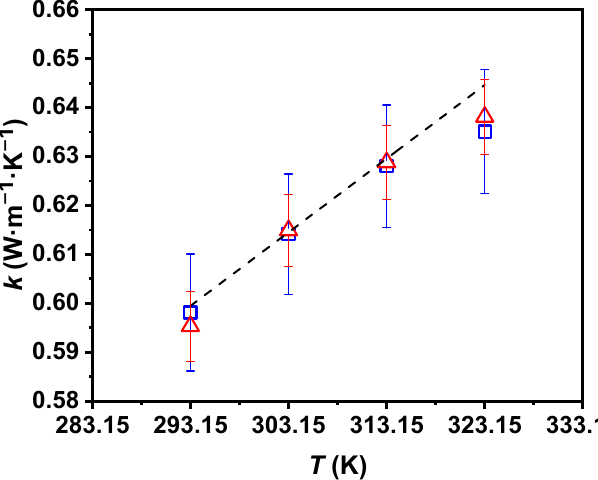
Figure 3. Experimental thermal conductivity, k , of 0.50 wt% P-GnP/W nanofluid (UVigo (cid:3) ; ILK laboratory, (cid:52) ) together with the literature k of water (- - -) [55] as a function of temperature, laboratory, □ ; ILK laboratory, △ ) together with the literature k of water (- - -) [55] as a function of T . Error bars indicate expanded uncertainty ( k = temperature, T . Error bars indicate expanded uncertainty ( k = 2).